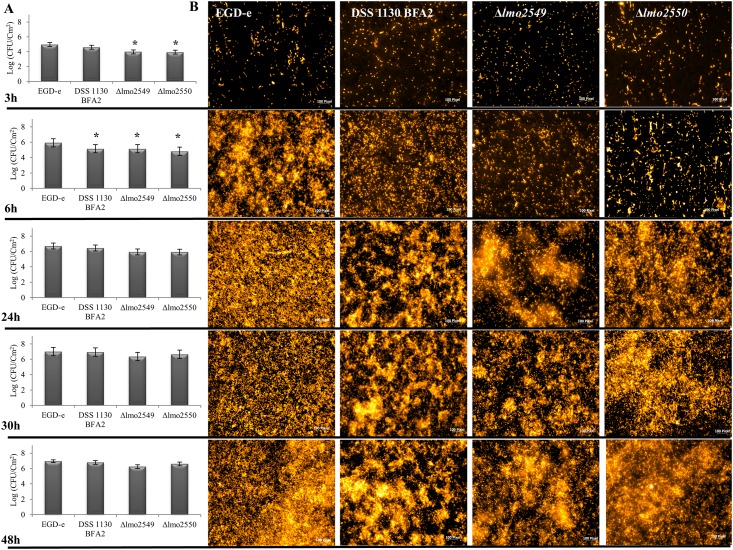
Adhesion to the formation of the 48-h biofilms by the DSS 1130 BFA2, EGD-eΔlmo2549 and EGD-eΔlmo2550 mutants and the wild-type EGD-e strain grown on stainless steel at 30°C in MCDB202 medium.(A) Enumeration of viable culturable population at t = 3 h; 6 h, 24 h, 30 h and 48 h. The error bars represent the standard deviation (n = 3) and * represent significant difference. (B) Observations by epifluorescence microscopy after staining at acridine orange at t = 3 h, 6 h, 24 h, 30 h and 48 h. The size bar of 100 Pixel indicated 5 μm.